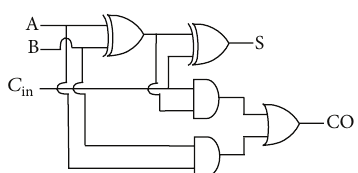
Figure 7: Regular full adder architecture [17].